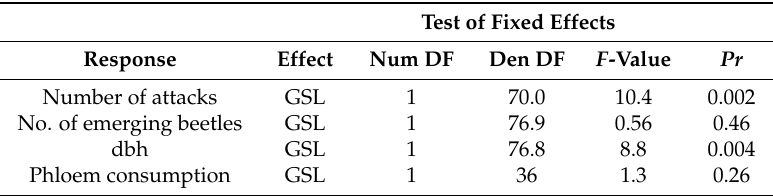
Table A2. ANOVA table for the Growing Stock Level (GSL) fixed effect for number of attacks, number of emerging beetles, diameter at breast height (dbh), and phloem consumption in their respective analysis.